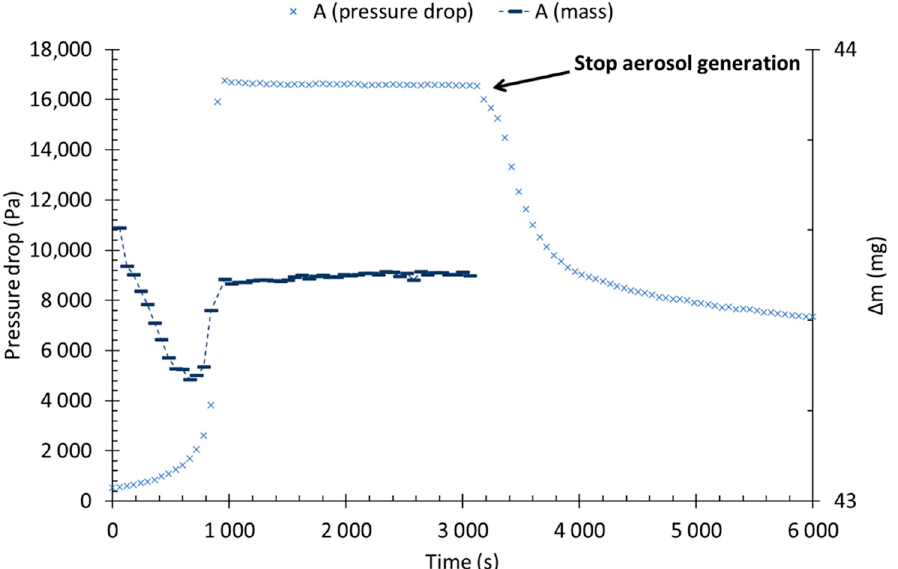
Figure 6. Pressure drop and collected mass, before and after the liquid aerosol stop, as a function of time at a filtration velocity of 6 cm/s (Filter A).